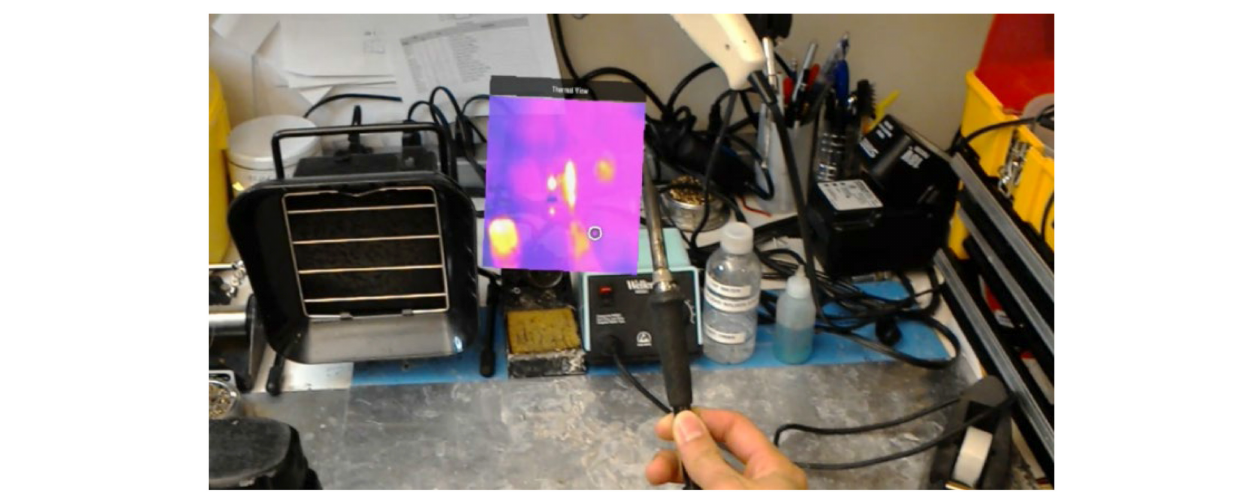
FIGURE 30 | 3rd-person view of a human operator using an augmented reality headset to determine the geometry for MCNP input files in-situ .